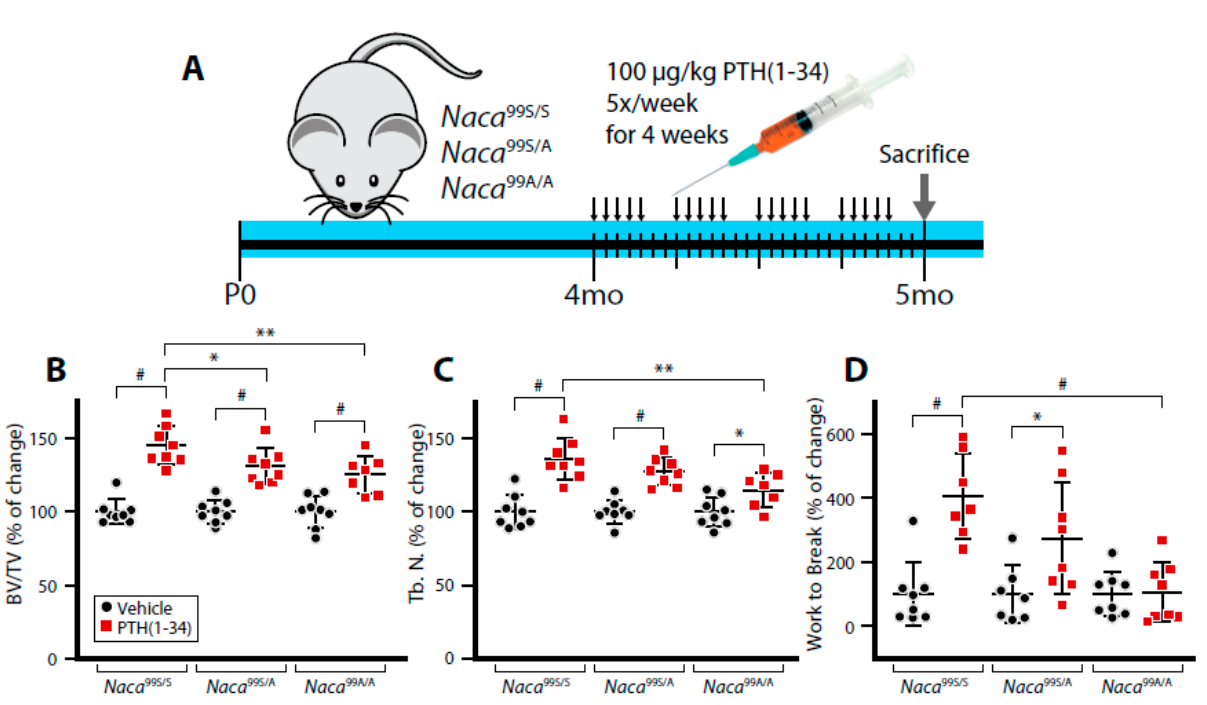
Figure 1. Mutation of the PKA phosphoacceptor site within the NACA sequence impairs the osteoanabolic response to intermittent PTH treatment. Four ‐ month ‐ old female mice were treated once daily, 5 days/week for 1 month with 100 μ g/kg of PTH(1 ‐ 34) ( A ). Vertebrae were analyzed by μ CT ( B , C ) and compression testing ( D ). BV/TV, bone volume/tissue volume; Tb. N., trabecular number. Results are expressed as change from vehicle ‐ treated animals, which are ascribed a value of 100%. * p < 0.05; ** p < 0.01; # p < 0.0001, two ‐ way analysis of variance (ANOVA) with post hoc tests.